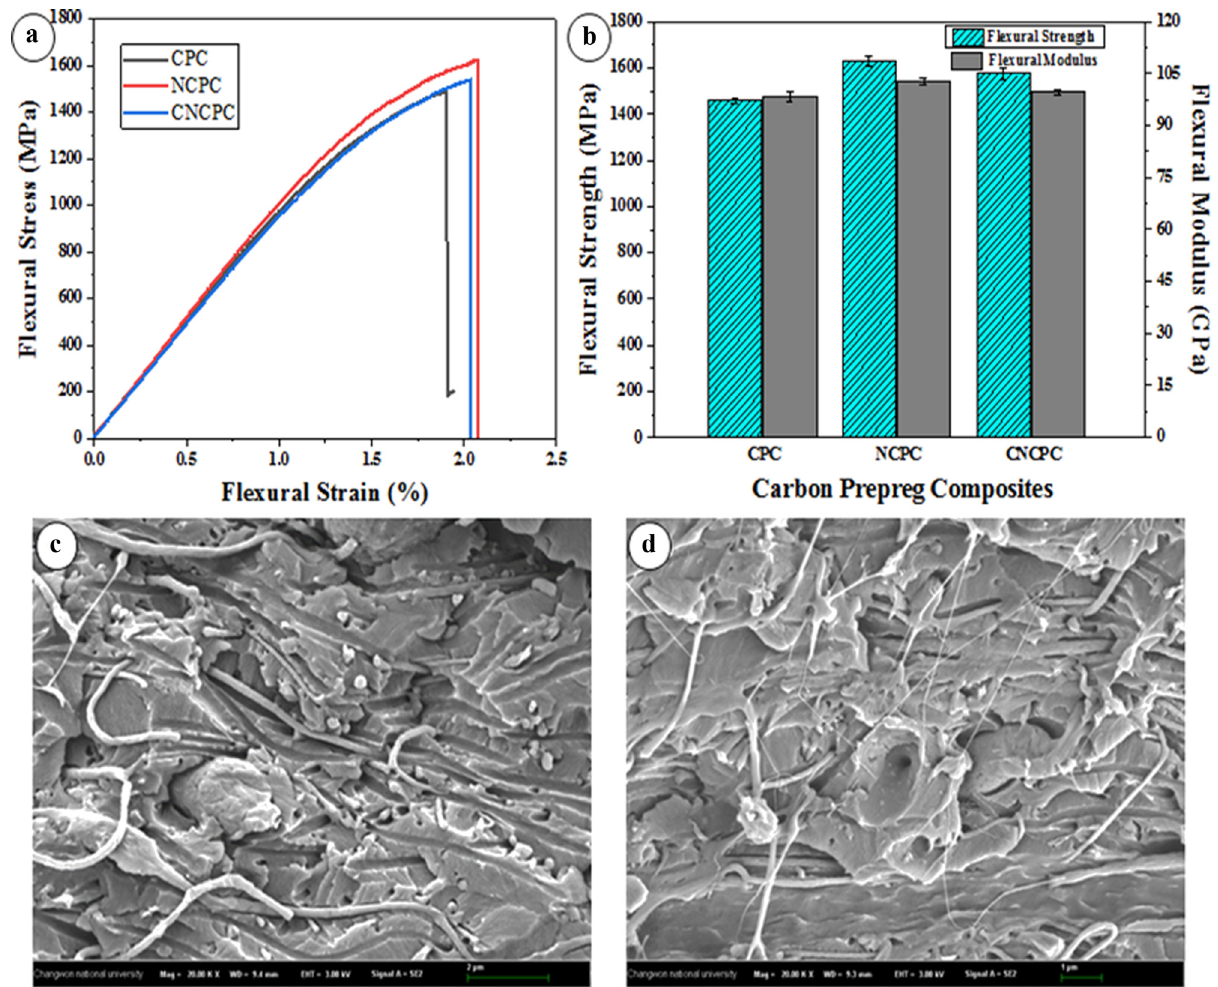
Figure 3: ( a and b ) Flexural test results of CPC, NCPC, and CNCPC composites, and ( c and d ) fracture SEM images of NCPC and CNCPC